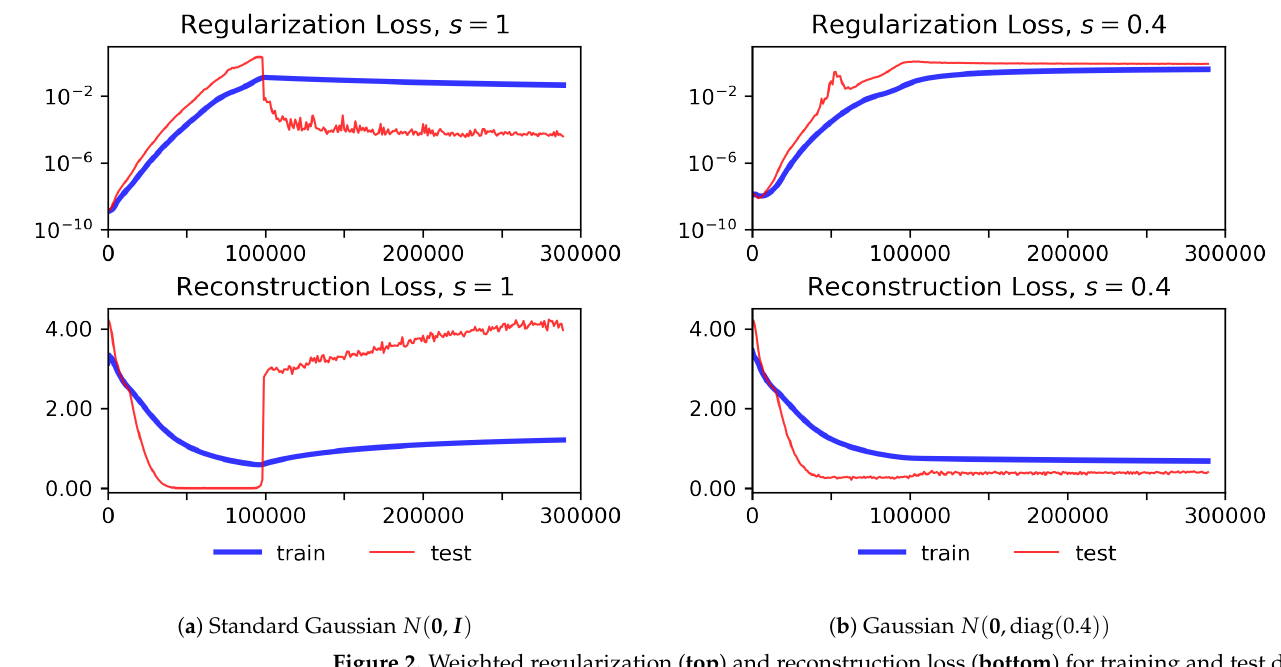
Figure 2. Weighted regularization ( top ) and reconstruction loss ( bottom ) for training and test data over several epochs for two different Gaussians applied as a prior distribution for the regulariza- tion